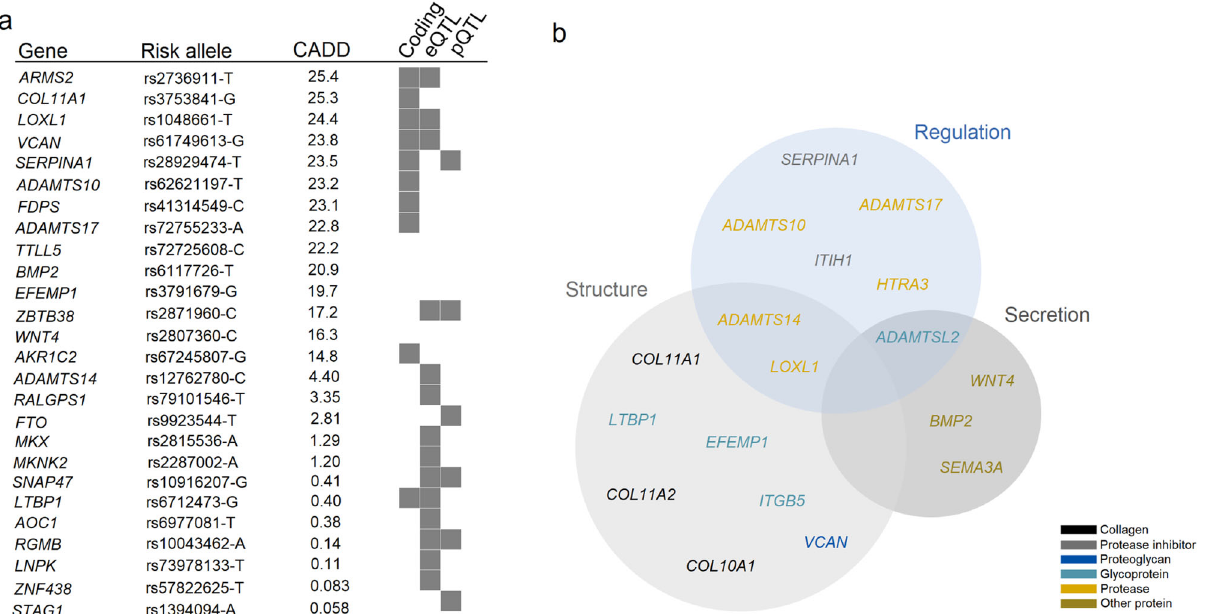
Fig. 2 Functional annotation and gene-set analysis. a Variants ( N = 22) with evidence pointing to a single effect-mediating gene in the form of protein- coding or splicing variants, variants affecting mRNA expression (top cis -eQTL) or plasma protein levels (pQTL), and variants ( N = 4) with evidence of pathogenicity (CADD score ≥ 12.4, suggested threshold for pathogenicity 64 ). b Gene-set enrichment analysis revealed an enrichment for genes encoding proteins that are components of the extracellular matrix. The Venn diagram divides the implicated genes into groups based on the functional role of the encoded protein in the extracellular matrix; regulation (blue), secretion (dark gray), and/or structure (light gray). Genes encoding proteins in different protein categories are colored black (collagens), gray (protease inhibitors), navy (proteoglycans), turquoise (glycoproteins), orange (proteases), and bronze (other proteins).